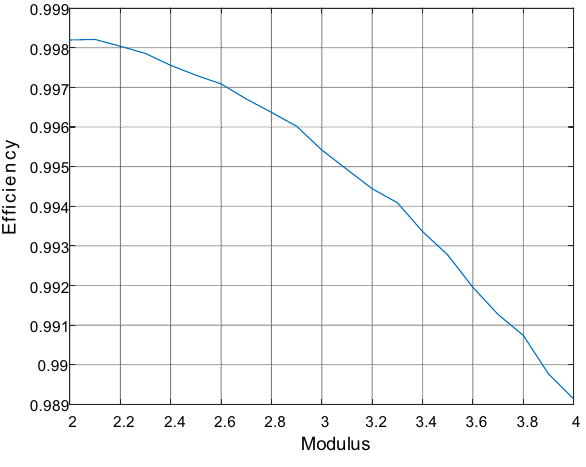
Fig. 10 Influence of modulus on relative sliding speed